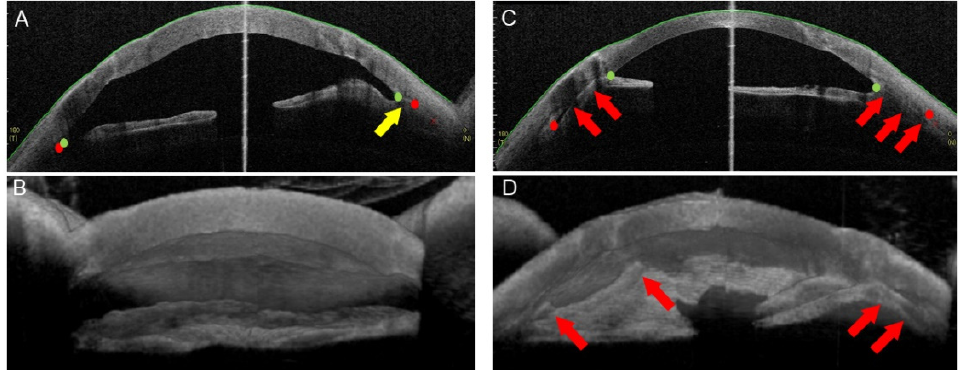
Figure 1. Three-dimensional anterior segment OCT analysis of ITC before and after PKP. Anterior segment OCT images of a representative patient before and after PKP. A 64-year-old woman with bullous keratopathy successfully underwent PKP. The total protein level in the aqueous humor was 1.55 mg/mL (0.3–0.4 mg/mL in normal eyes). Before PKP ( A , B ), the patient had limited ITC on the nasal side (yellow arrows). After PKP ( C , D ), ITC developed on the nasal side and expanded on the temporal side (red arrows). The red points represent the scleral spurs. The green points indicate the peripheral endpoint of the iris.